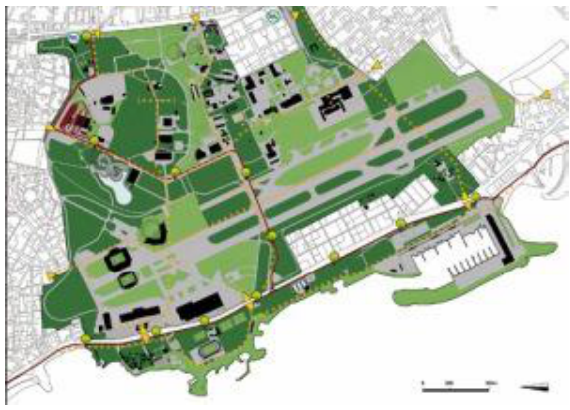
Fig 4. N. Belavilas et al, Master Plan of Ellinikon Former Airport Metropolitan Park of Athens, Urban Environment Laboratory, School of Architecture, NTUA (2010):